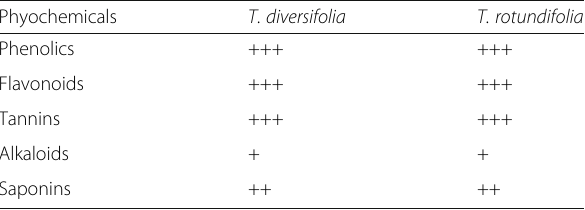
Table 4 Phytochemicals qualitatively detected in leaf extracts of T . diversifolia and T .